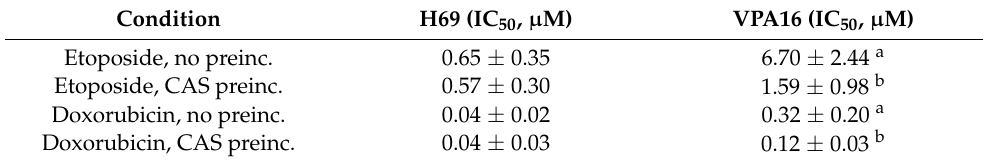
Table 1. Reversal of multi-drug resistance by castasterone.